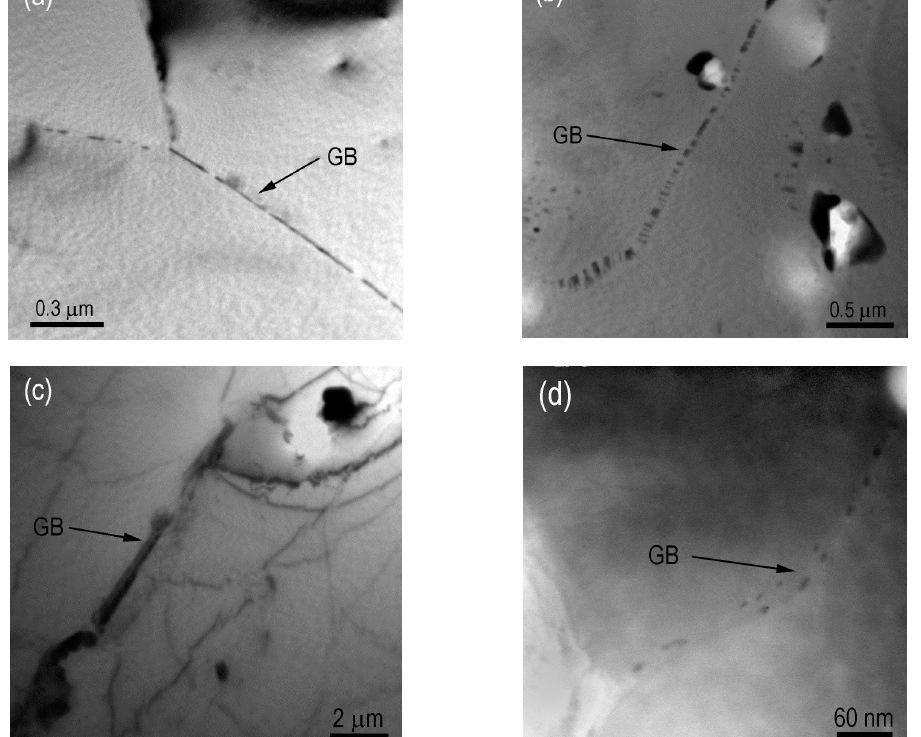
Figure 4. TEM micrographs: ( a ) Al-20 wt.% Zn alloy before HPT-treatment at T = 350 °C, ( b ) Al-20 wt.% Zn alloy after HPT-treatment at T = 320 °C, ( c ) Al-10 wt.% Mg before HPT-treatment at T = 400 wt.% Zn alloy after HPT-treatment at T = 320 ◦ C; ( c ) Al-10 wt.% Mg before HPT-treatment at T = 400 ◦ C; °C, ( d ) Al-10 wt.% Mg alloy after HPT-treatment at T = 400 °C. ( d ) Al-10 wt.% Mg alloy after HPT-treatment at T = 400 ◦